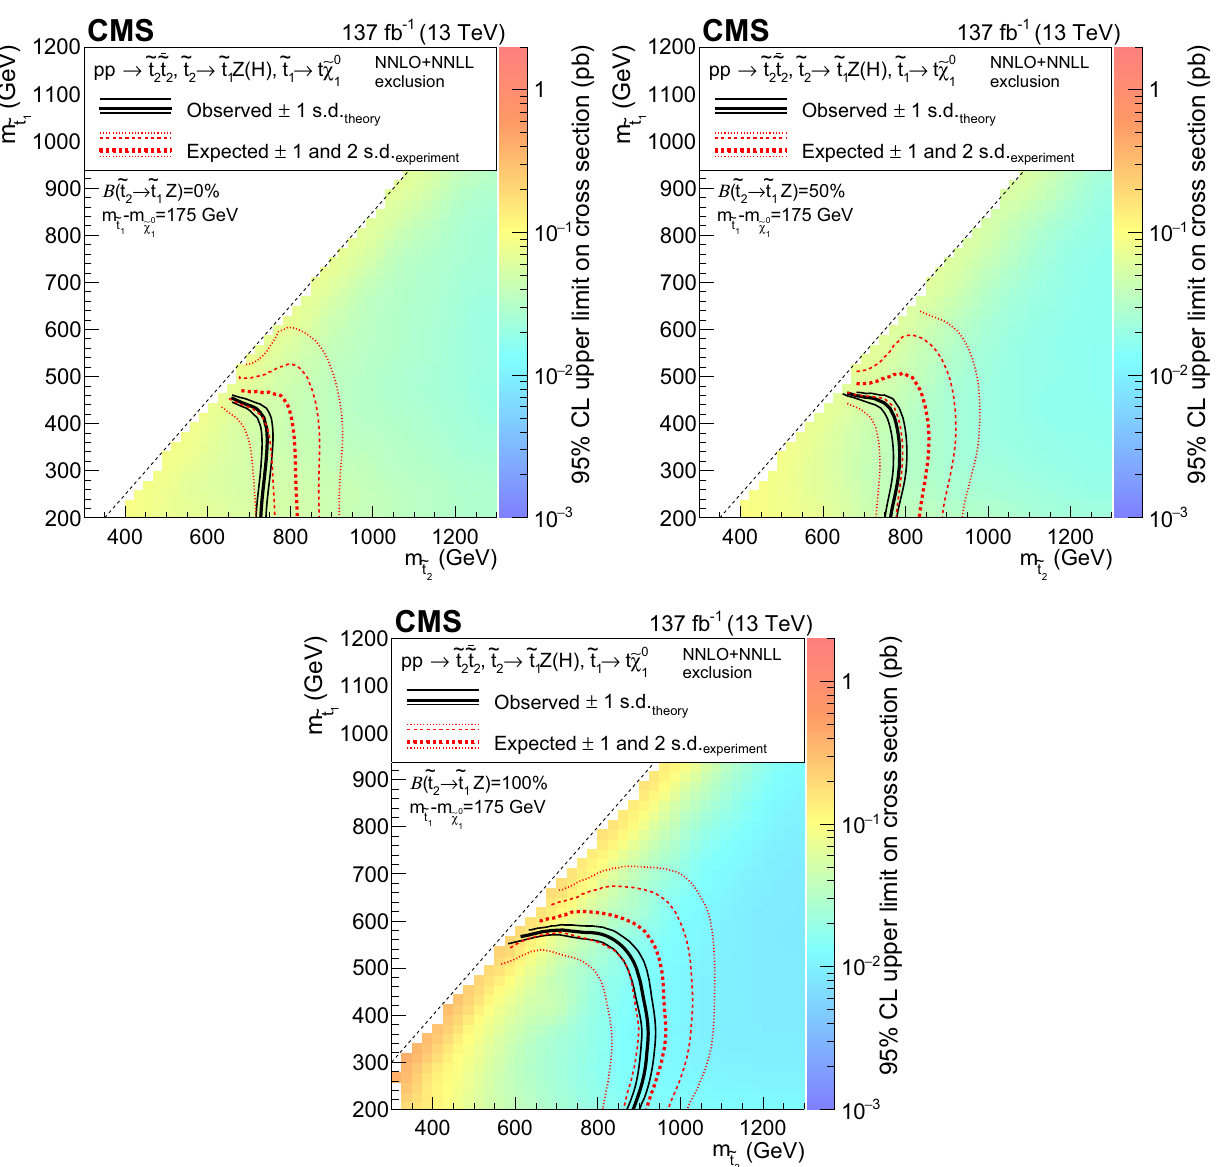
) = 175GeV. The three 1